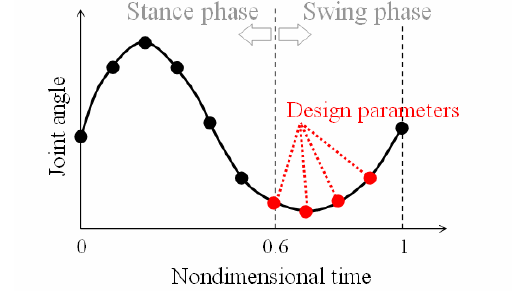
Fig. 5 Scheme of the design